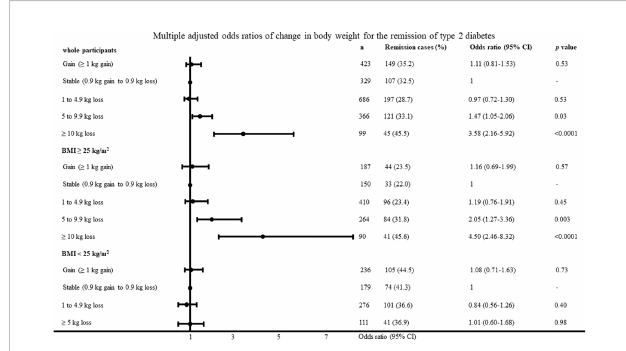
FIGURE 1 Multiple adjusted odds ratios of change in body weight for the remission of type 2 diabetes adjusted for age, body mass index, systolic blood pressure, low-density lipoprotein cholesterol, high- density lipoprotein cholesterol, triglyceride, fasting plasma glucose, uric acid, smoking habit and physical